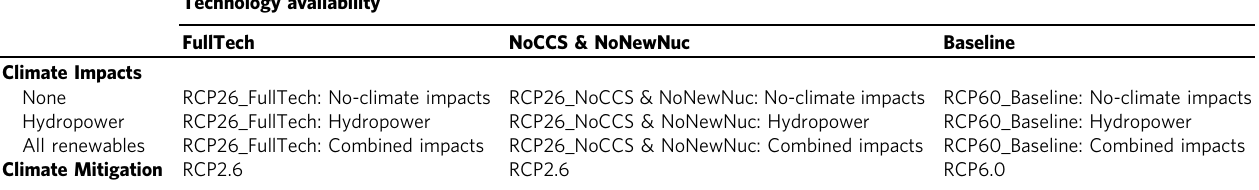
Table 1 Scenarios explored in this